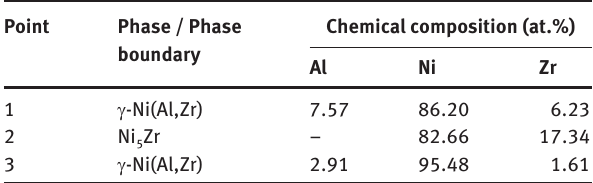
Table 2: Chemical composition of the coating deposited by EB-PVD method after diffusion treatment process after 4 h at 1325 K.